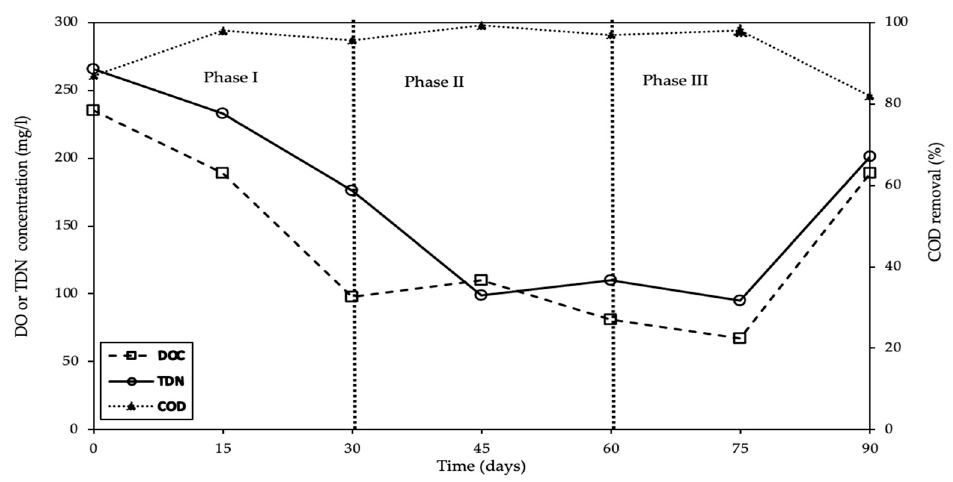
Figure 6. Total dissolved nitrogen (TDN), dissolved organic carbon (DOC) and organic matter (COD) concentrations at different phases of treatment.